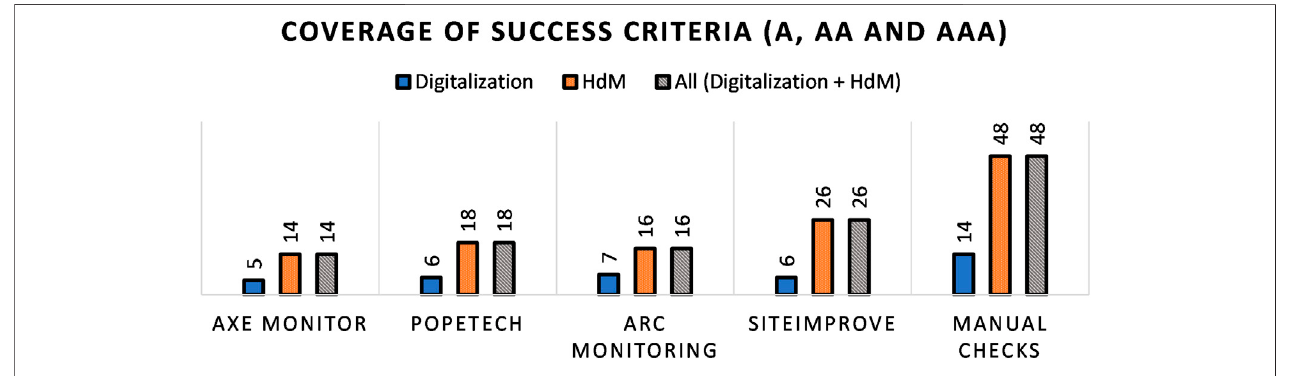
FIGURE 5 | Coverage of success criteria based on WCAG 2.1 AAA.